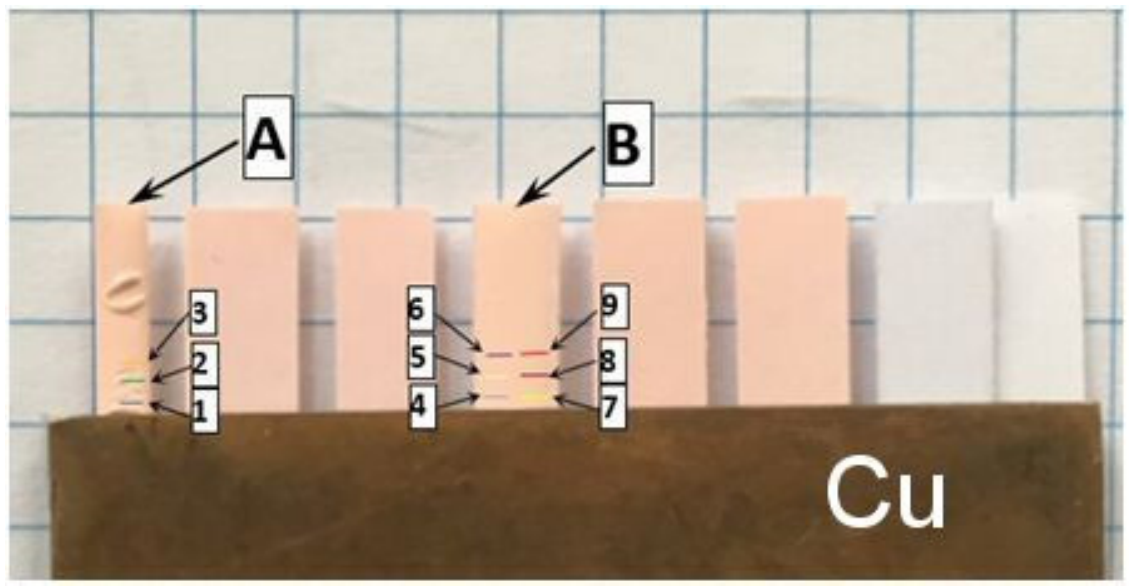
Figure 10. View of specimens prepared for infrared TD measurement by temperature oscillation with indication of control lines on the investigated TSP–paper composite specimens.